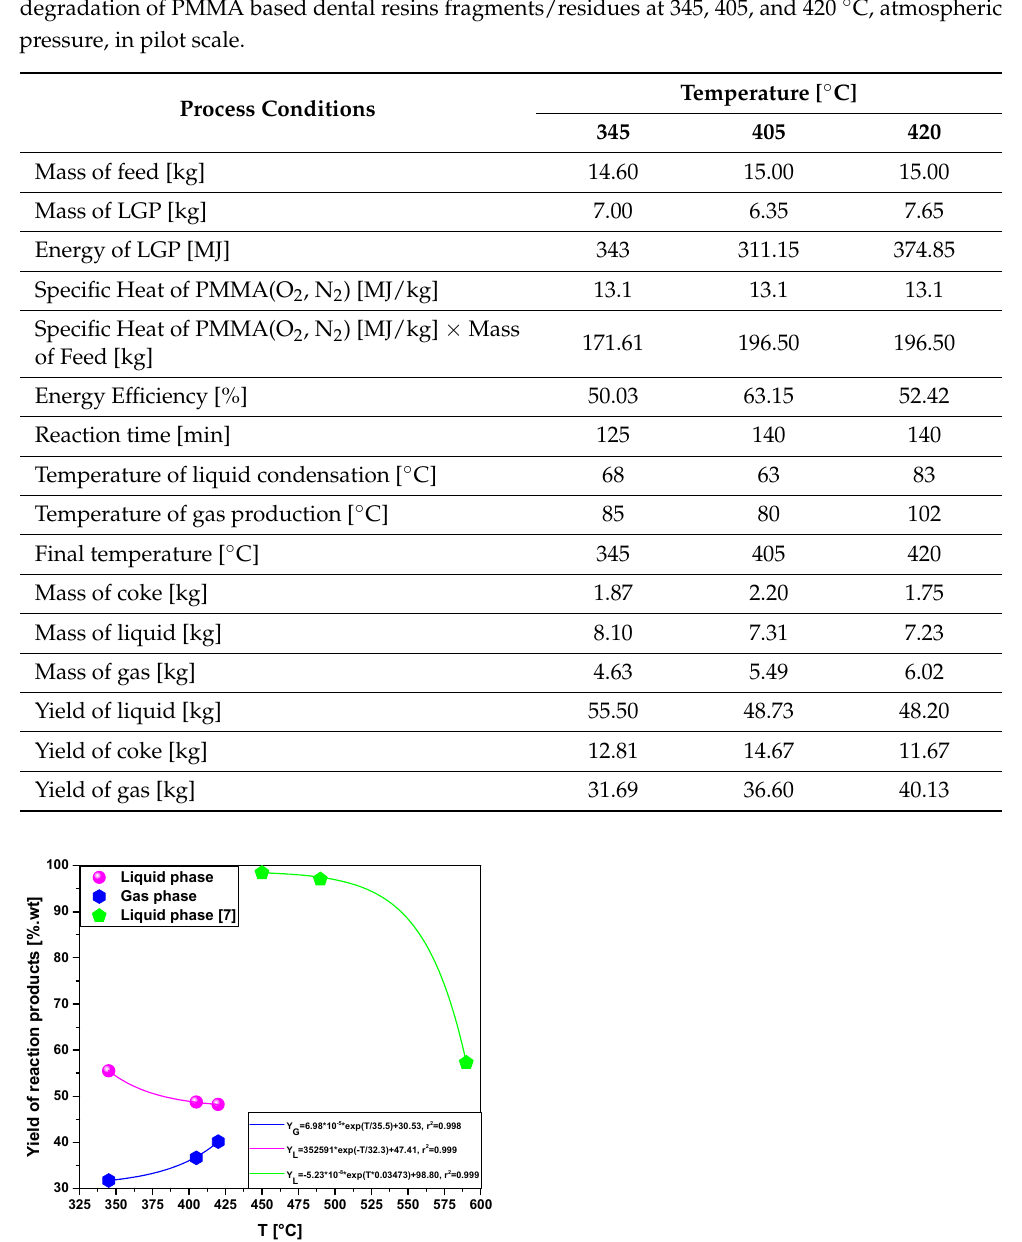
Figure 5. Yield of liquid and gaseous phase products by depolymerization of PMMA based dental resins fragments/residues at 345, 405, and 420 °C and atmospheric pressure, in pilot scale, compared to Kaminsky and Frank [7].